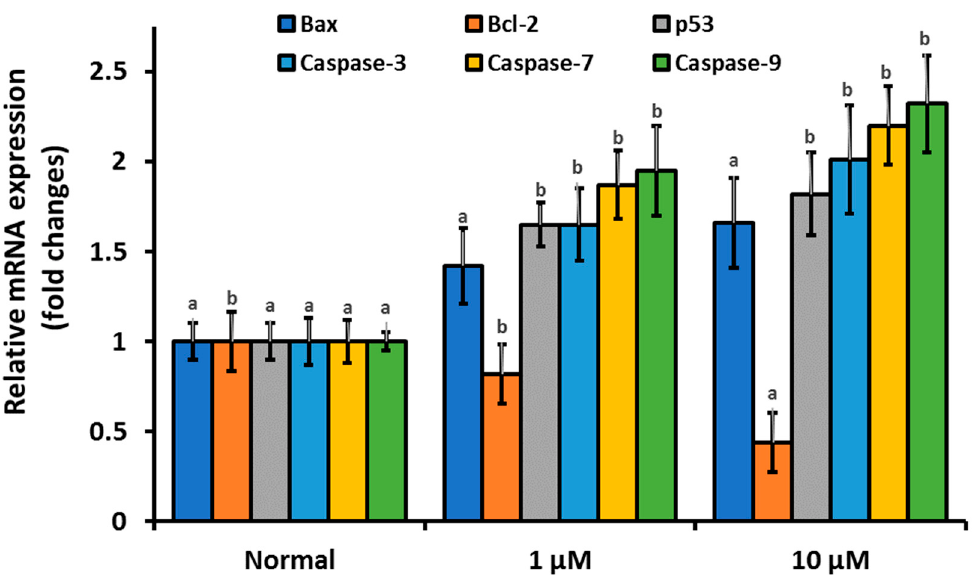
Figure 4. The mRNA expression profile of anti-apoptotic Bcl-2 and pro-apoptotic tumor protein p53, Bax, and caspase-3, -7, and -9 in HeLa cells treated with β -cryptoxanthin (1.0 and 10 µM) for 24 h. All data are reported as mean values ± SD from independent experiments ( n = 3). The means accompanied by different alphabets (e.g., a and b) are significantly different at p < 0.05.